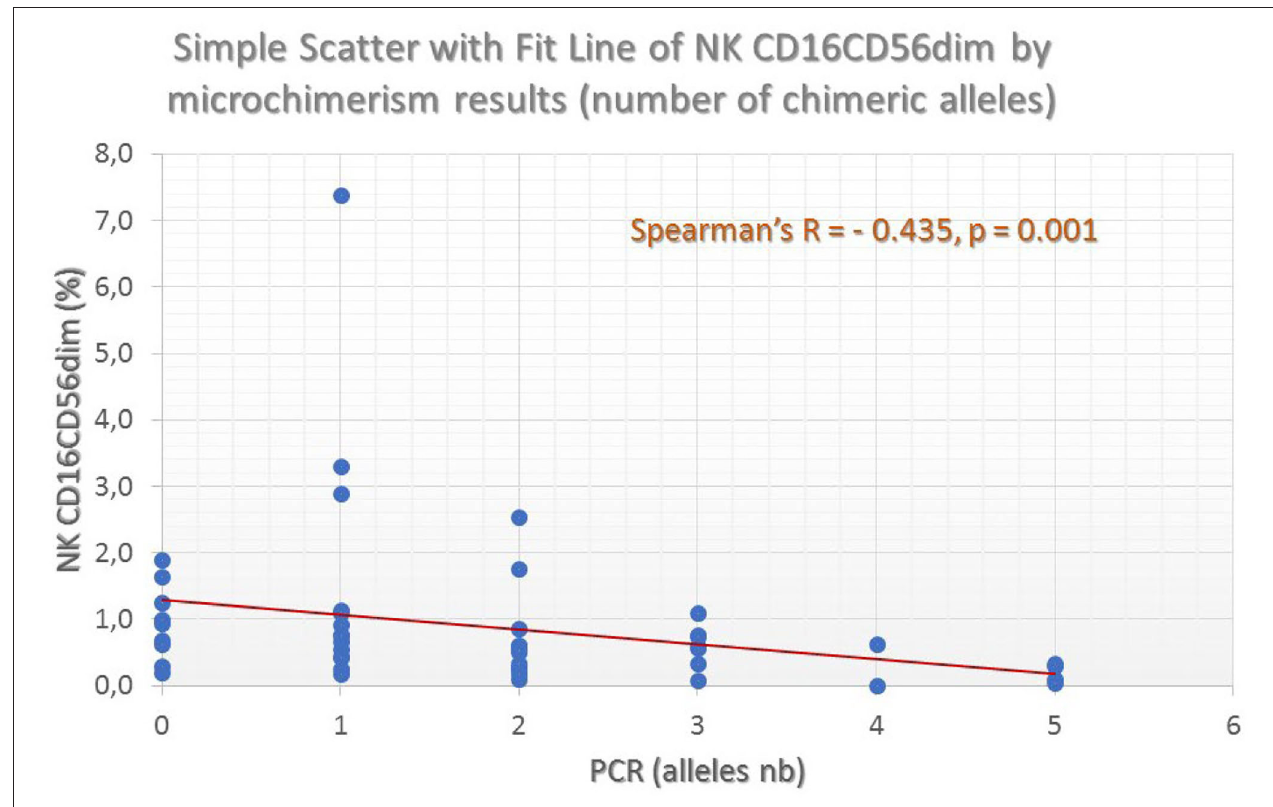
FIGURE 5 | Fluctuation of mature NK-cell frequencies (as defined by the CD16 dim CD56 dim co-expression profile) by the number of chimeric alleles detected in the thalassemic patient population. A clear and significant inverse association can be seen.